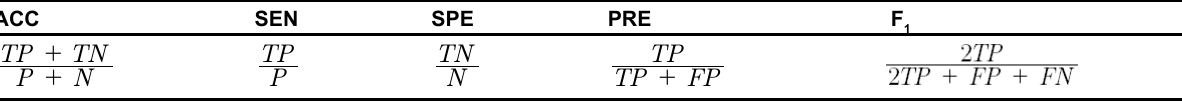
CNN-based feature extraction of IHC